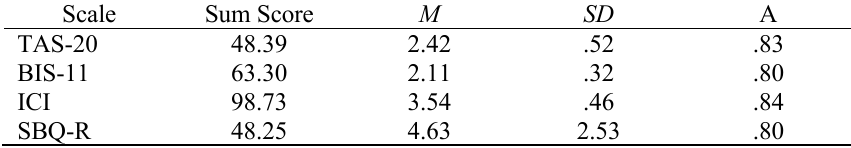
Table 1. Scale Sums, Means, Standard Deviations, and Internal Consistencies